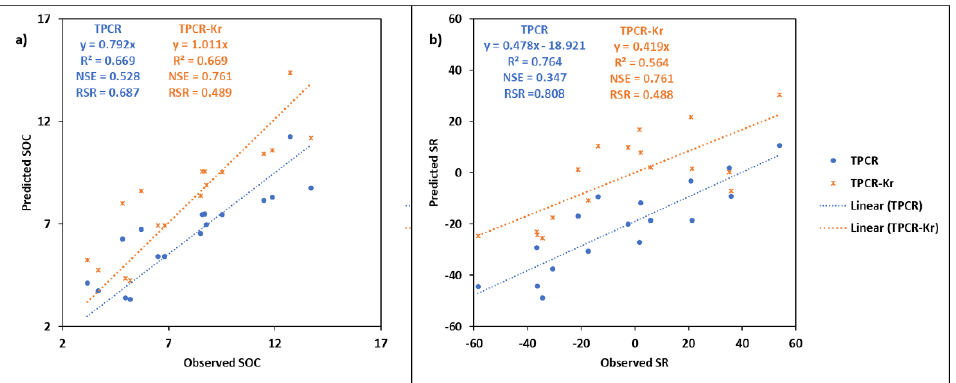
Figure 5. Comparison of topographic principal component regression (TPCR, blue data points) and TPCR-kriging (TPCR-Kr, orange data points)-derived ( a ) soil organic carbon (SOC) density (kg m − 2 ) and ( b ) soil redistribution (SR) rate (Mg ha − 1 year − 1 ) predictions for observations at field site 2.